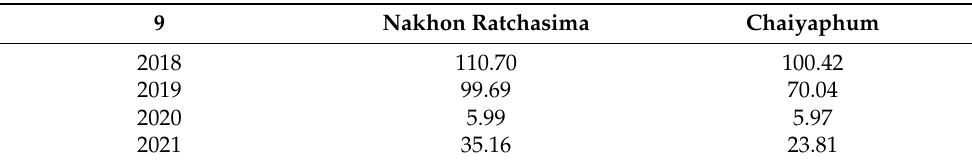
Table 1. The occurrences of the HFMD in Nakhon Ratchasima and Chaiyaphum between 2017 and 2021 (per 100,000 population)